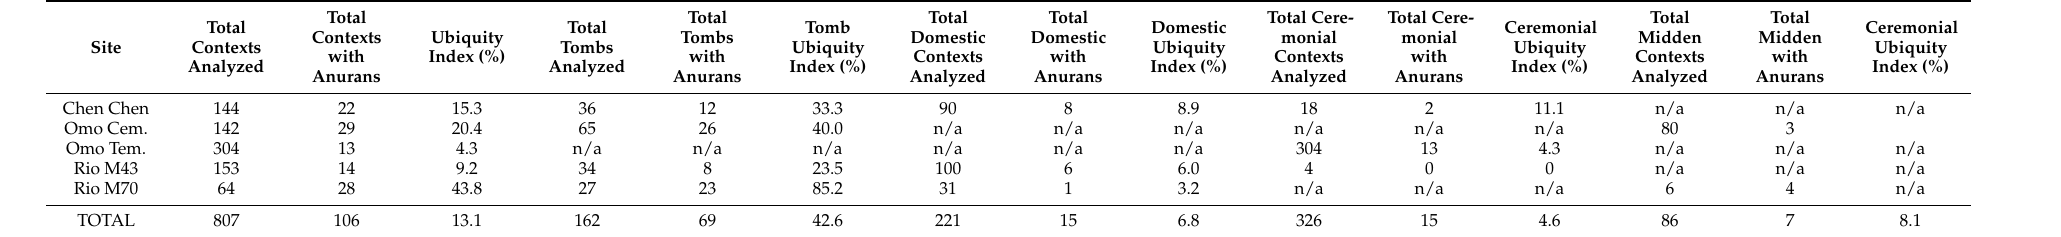
Table 5. Contexts and Ubiquity Index by site and context